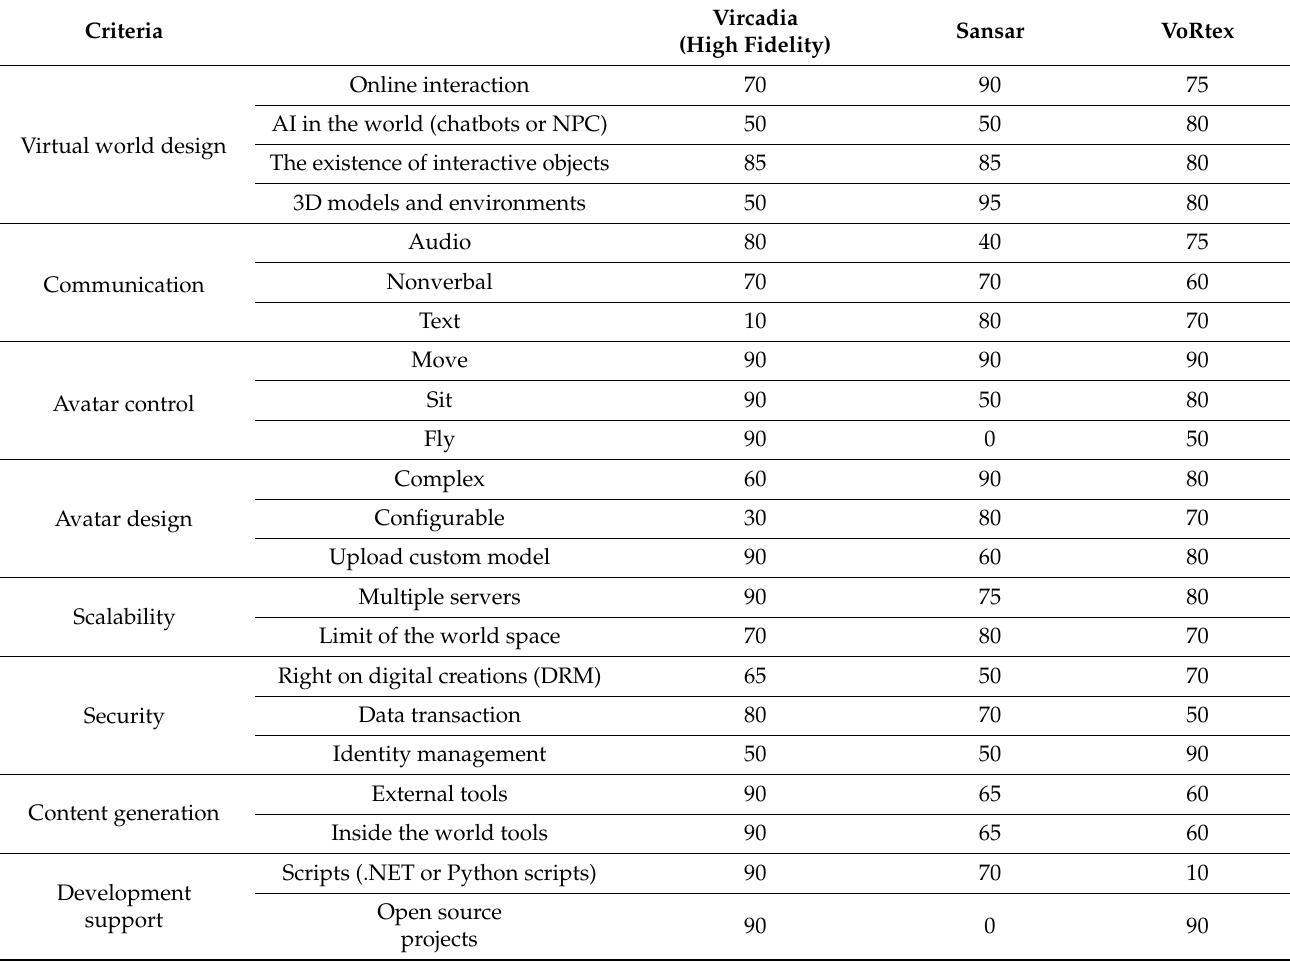
Table 1. Mannien’s matrix for the relevant value assigned to virtual worlds.